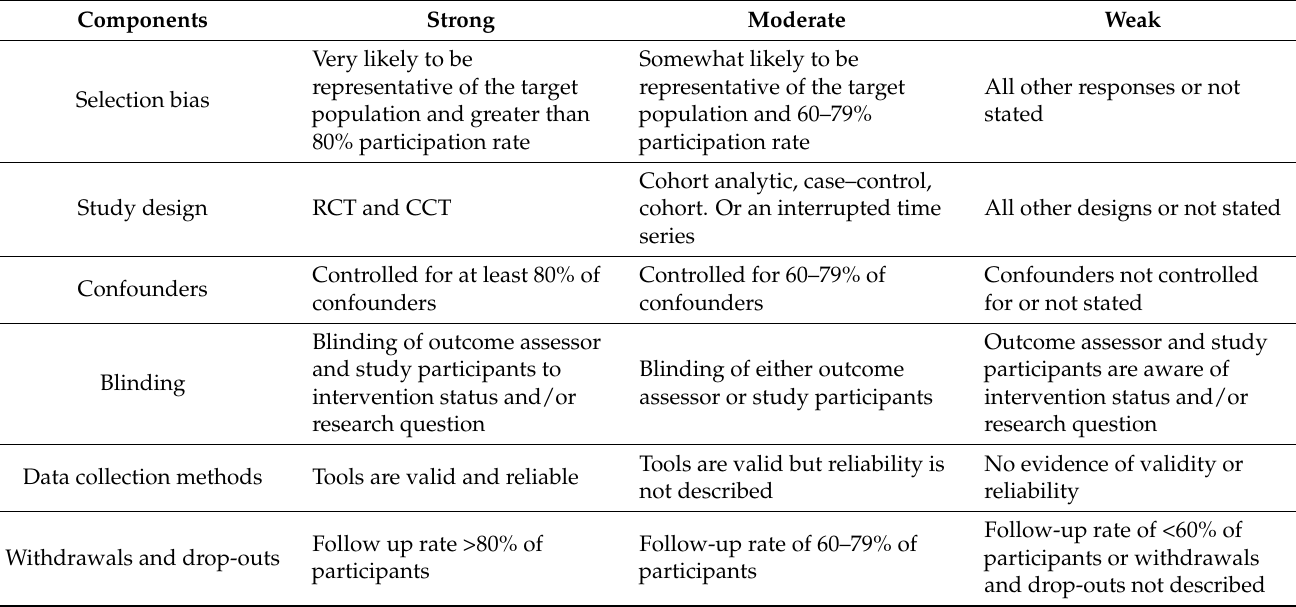
Table 1. Quality assessment components and ratings for EPHPP instruments reproduced from Thomas BH, Ciliska D, Dobbins M, Micucci S. A process for systematically reviewing the literature: providing the research evidence for public health nursing interventions. Worldviews Evid Based Nurs. 2004. [23], with permission from John Wiley and Sons, Copyright © 2004 (License